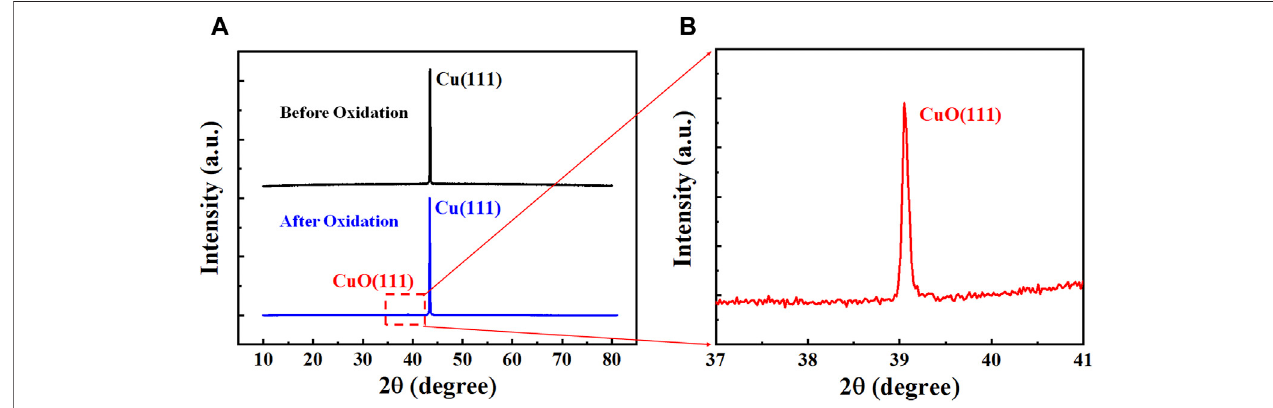
FIGURE 4 | XRD characterization of copper foil. (A) XRD patterns obtained by a 2 θ scan of the Cu (111) ( ∼ 43.3 ° ) foil before (black) and after oxidation (red). (B) Zoom-in XRD pattern obtained by a 2 θ scan, showing the CuO (111) peak at 38.7 °